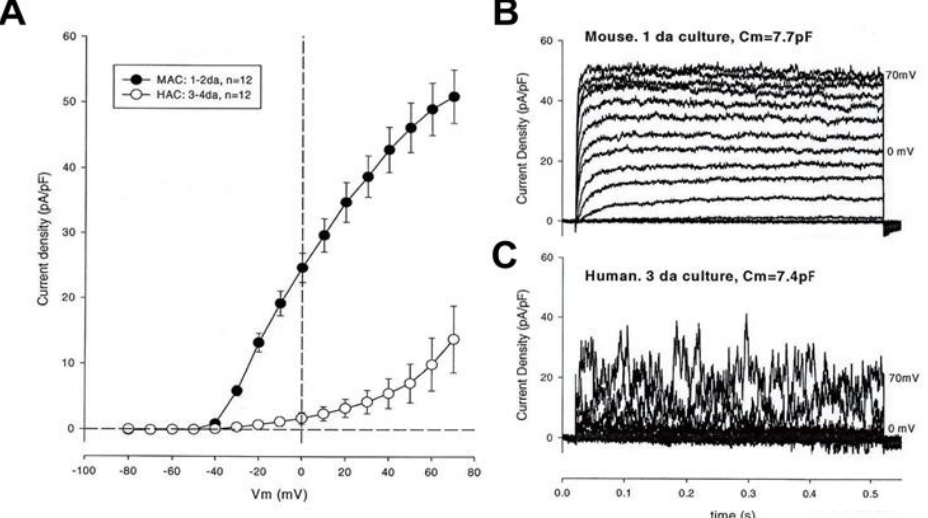
Figure 2. Qualitative comparison of transmembrane K + currents recorded from single isolated murine and human articular chondrocytes that were maintained in primary culture. The two superimposed families of currents in ( B ) and ( C ) on the right show marked di ff erences in quantitative features between recordings from mouse (MAC) vs. those from humans (HAC). The two superimposed current voltage curves in ( A ) of this Figure further illustrate these di ff erences (Clark and Giles, unpublished). Our previously published papers have revealed quite marked di ff erences in the relative functional expression of K + currents when murine [16], canine [20] and human [15] data sets are compared. Detailed methods can be also found in these previously published articles.